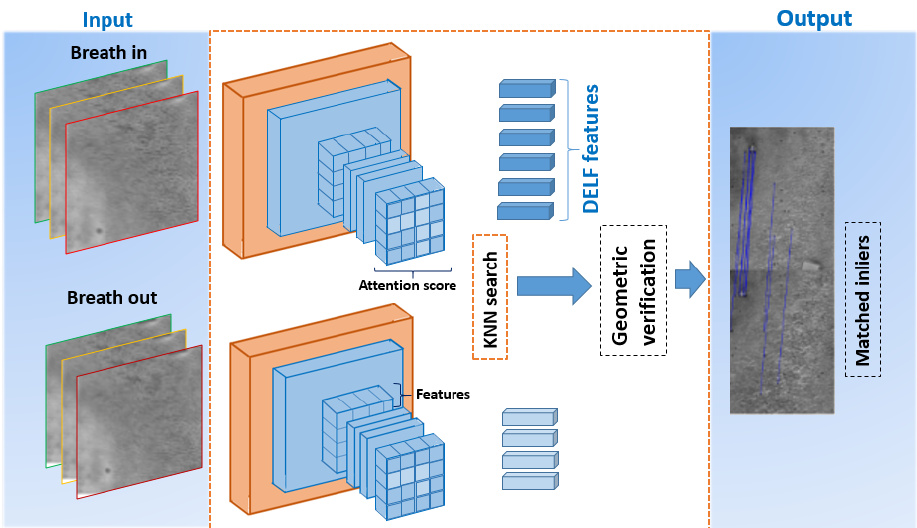
Figure 5. Architectures for feature extraction and matching adapted from Noh et al. [39]. The left panel shows the input HS data corresponding to the two different breathing phases. The middle panel depicts the feature extraction, indicating the attention scores assigned to relevant features and used for feature selection. The matched features are shown as the final output of the system in the right panel. KNN: K nearest